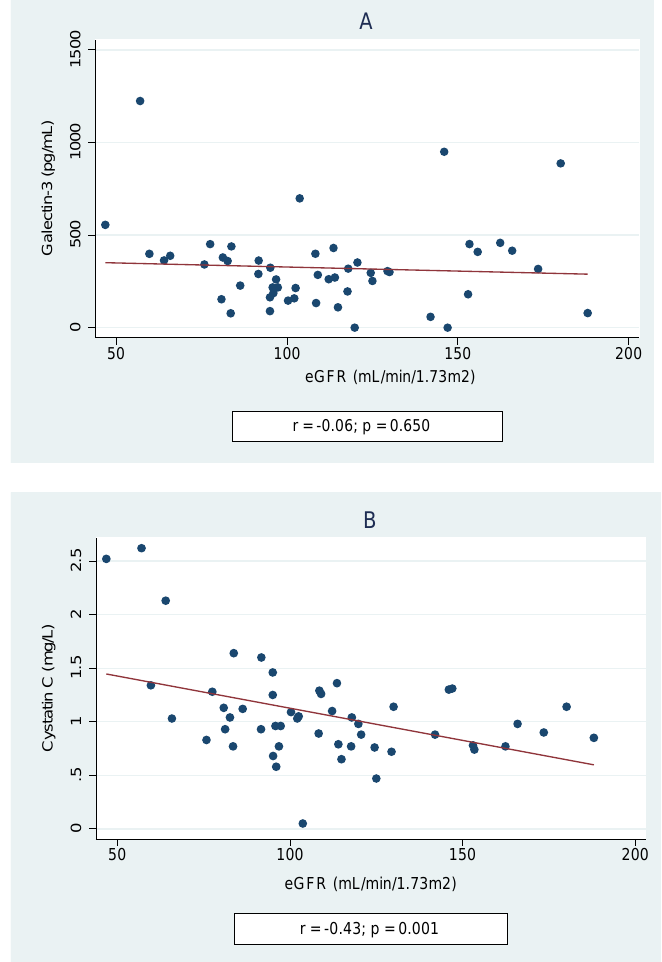
Figure 2. Spearman correlations of galectin-3 ( A ) and cystatin C ( B ) according to estimated glomerular filtration rate (eGFR).